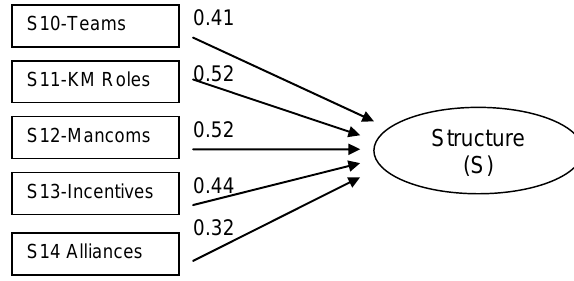
Figure 4: Relative weights of the Structure indicators